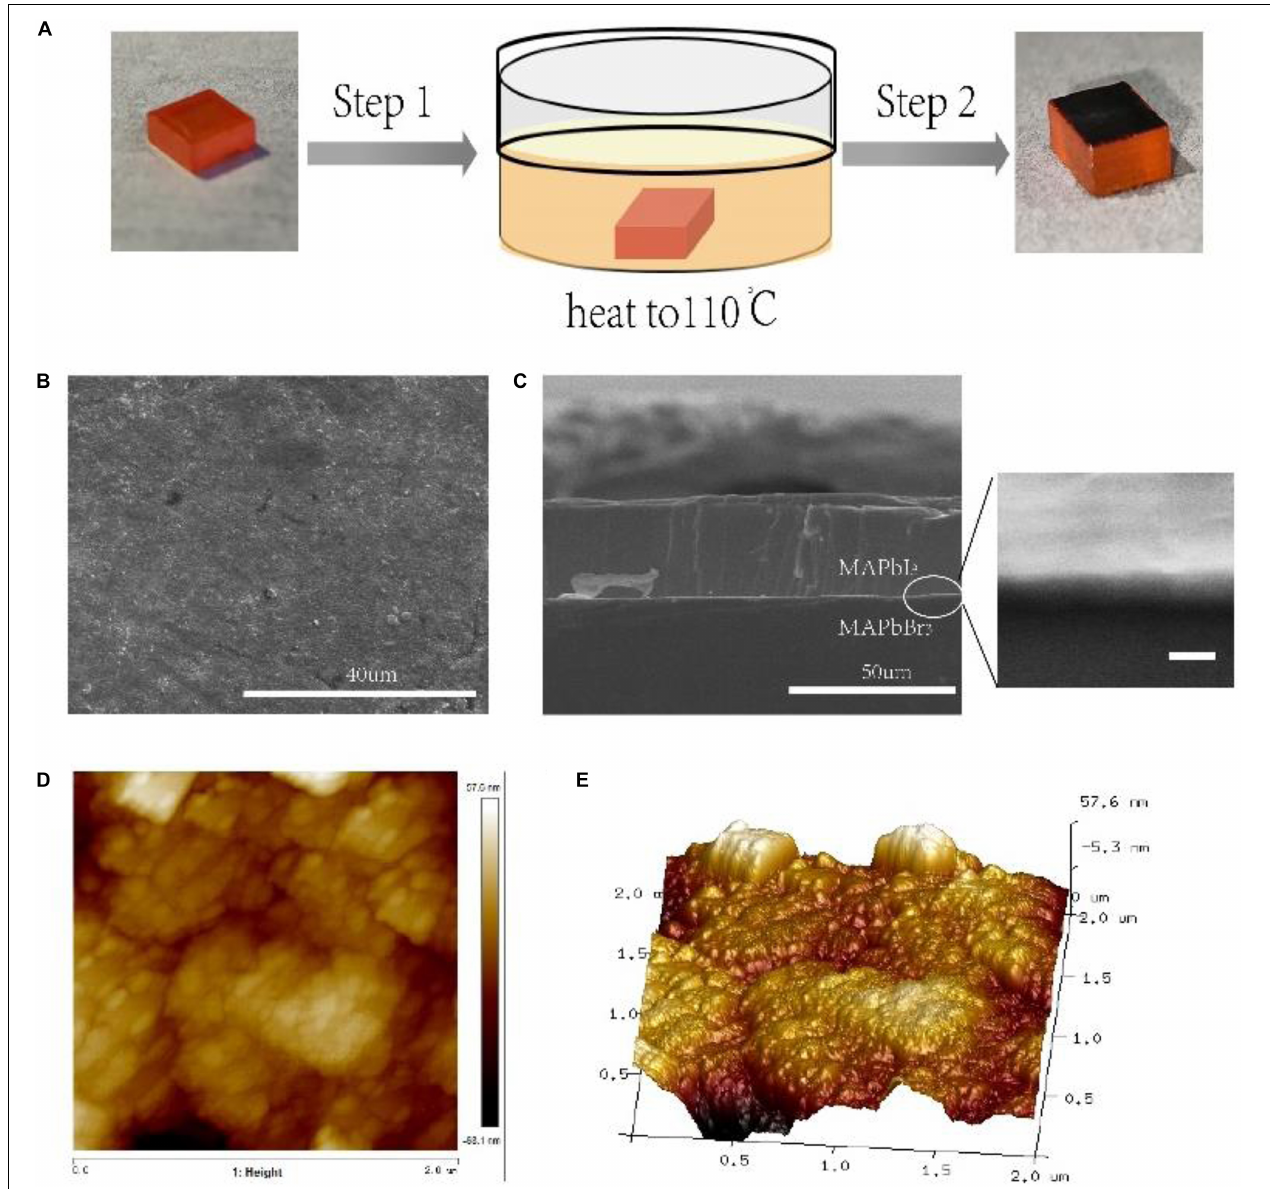
FIGURE 1 | (A) Processing of epitaxial growth of MAPbI 3 SCF via solution-process epitaxy. Step 1: put substrate into precursor solution of MAPbI 3 . Step 2: Cutting and polishing. (B) SEM image of the epitaxial MAPbI 3 SCF surface. (C) SEM image of the cross section of the epitaxial MAPbI 3 SCF on MAPbBr 3 single crystal substrate. The small figure is SEM image of the interface of the epitaxial layer and substrate with 1 µ m scale. (D) Atomic force microscope (AFM) image of the surface of